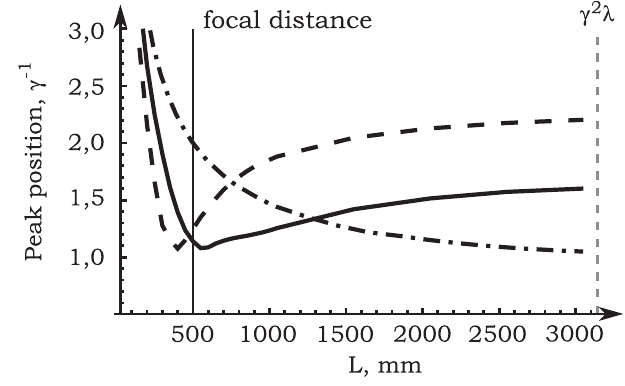
FIG. 4. The dependence of both polarization OTR peak posi- tion vs target-detector distance for the tilted parabolic target with f ¼ 500 mm (solid curve— Xd direction; dashed curve— Yd direction) and the same dependence for the flat target (dash- and-dotted curve).